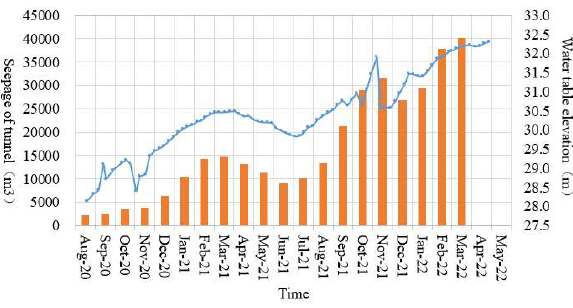
Figure 7. Variation curve of groundwater level and leakage in Liuliqiao ~